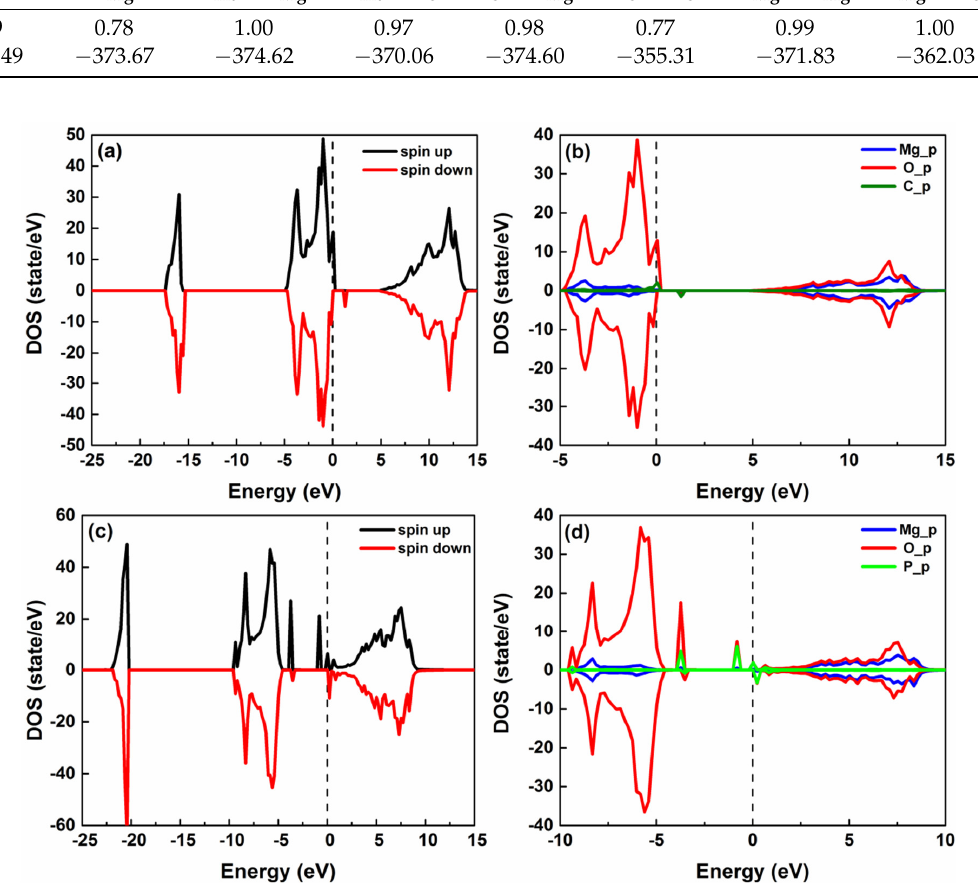
Figure 7. Total and partial spin-polarized DOS for the configuration of ( a , c ) V Mg + C O in the C-im- planted systems and ( b , d ) V Mg + P int in the P-implanted